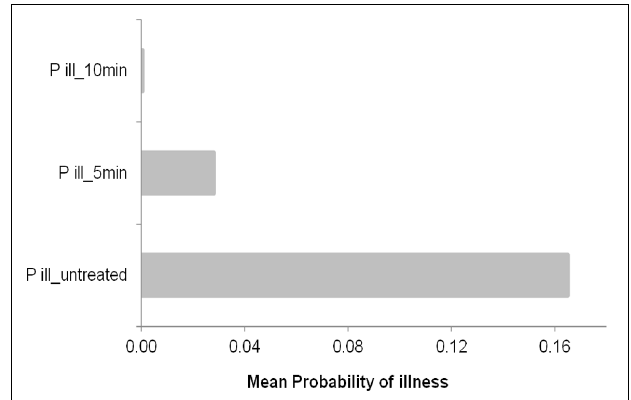
FIGURE 4 | Mean probability of illness by consumption of PIF contaminated with a concentration of cells (taken from Figures 3C1–C3, stochastic approach at 50 h of incubation at 15 ◦ C of a single cell survivor to 50 ◦ C for 5 and 10 min). The control is also showed as untreated cells and the prevalence is included as a uniform distribution between 3 and